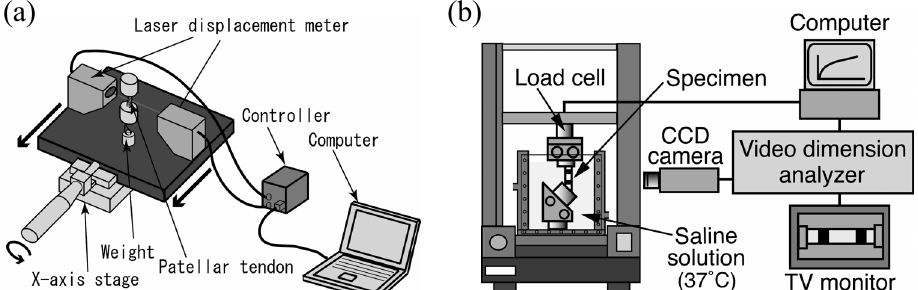
Apparatus for the measurement of cross-sectional area of patellar tendons (a) and a tensile tester used to determine the mechanical properties of the tendons